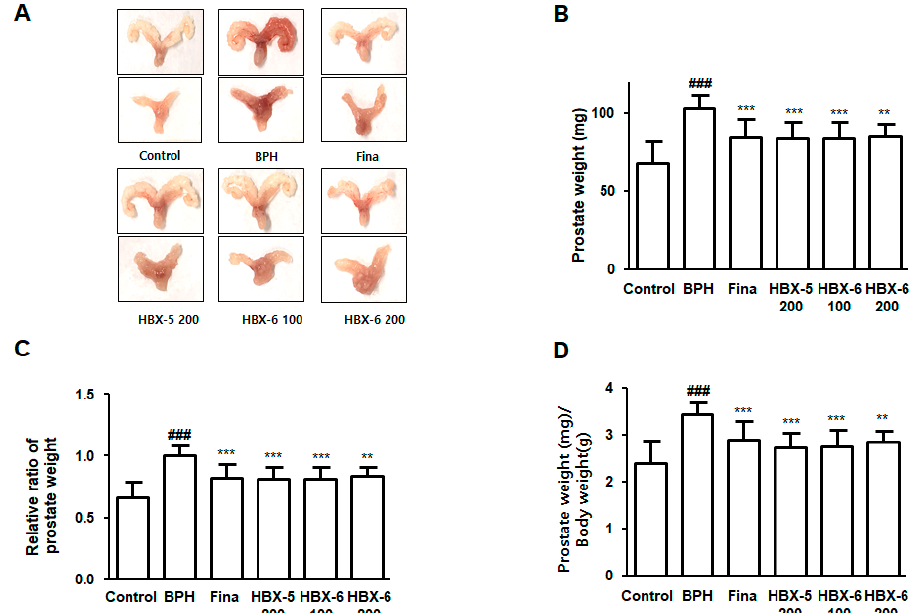
Figure 5. Effect of HBX-6 on prostate weight and prostate index in BPH-induced mice models. ( A ) A photographic assessment of prostatic enlargement from each experimental group is revealed. Change in ( B ) total prostate weight of the mice, ( C ) relative prostate weight ratio and ( D ) PW/BW ratio was assessed for the control, BPH, Fina, HBX-5 200 mg/kg, HBX-6 100 mg/kg and 200 mg/kg groups. Values were presented as mean ± SD ( n = 10); ### p < 0.001 versus control group; * p < 0.05, ** p < 0.01, *** p < 0.001 versus the BPH group; ANOVA and Dunnett’s post hoc test were used for significances between each experimental group.